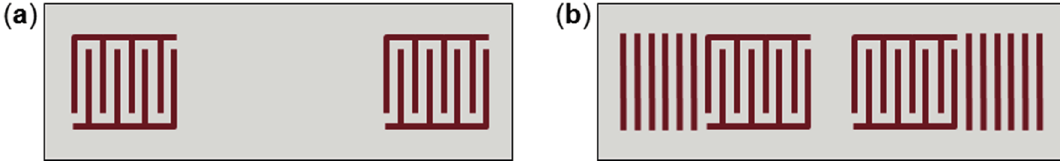
Figure 1. SAW sensor configurations ( a ) delay line ( b ) resonator